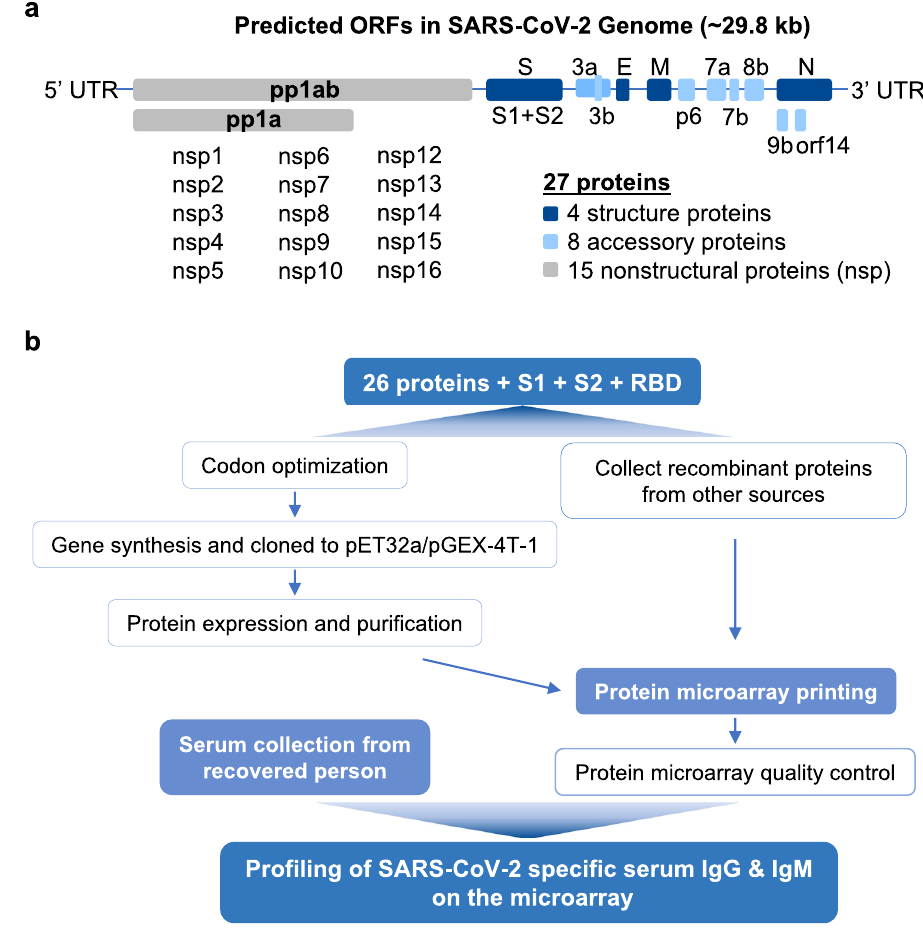
Fig. 1 The work fl ow of SARS-CoV-2 proteome microarray fabrication and serum pro fi ling. a The genome of SARS-CoV-2 and the 28 predicted proteins. b The work fl ow of proteome microarray fabrication and serum pro fi ling on the